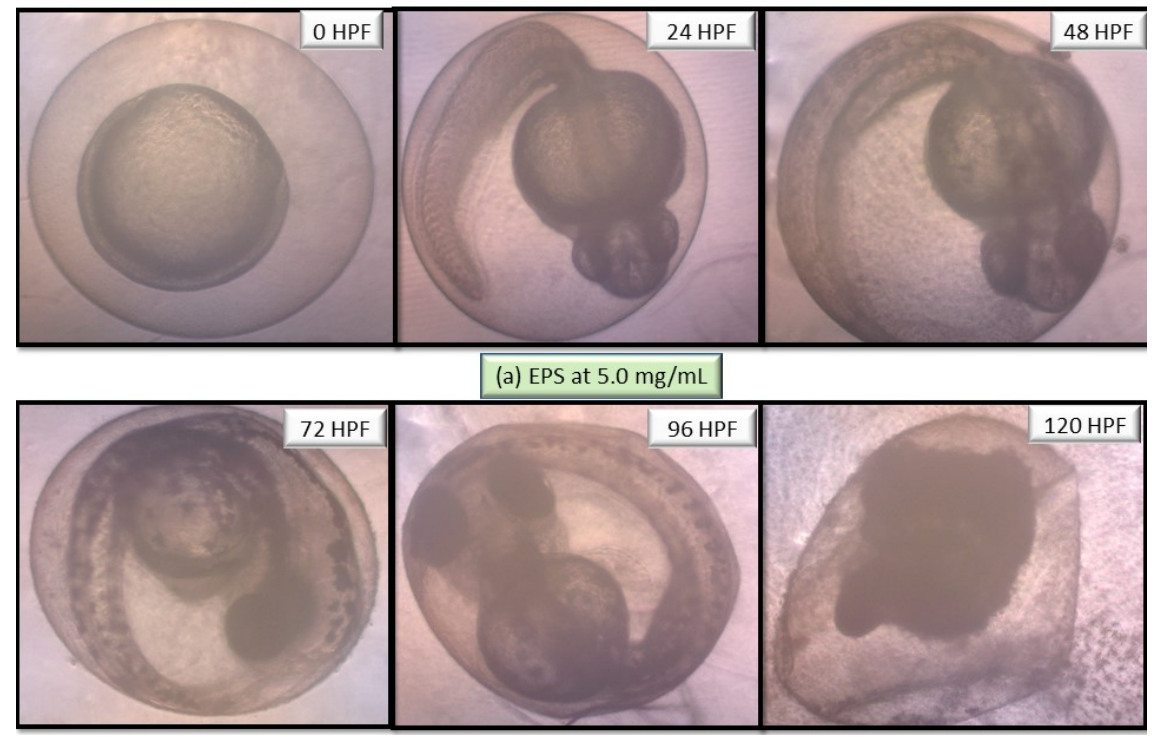
Figure 6. Images of zebrafish embryo and larvae development at 0 HPF, 24 HPF, 48 HPF, 72 HPF, 96 HPF and 120 HPF after treated with European Ganoderma applanatum at high EPS concentration of 5.0 mg/mL. Images were captured using inverted microscope at 100 × (0 and 24 HPF) and 40 × magnification (48–20 HPF).